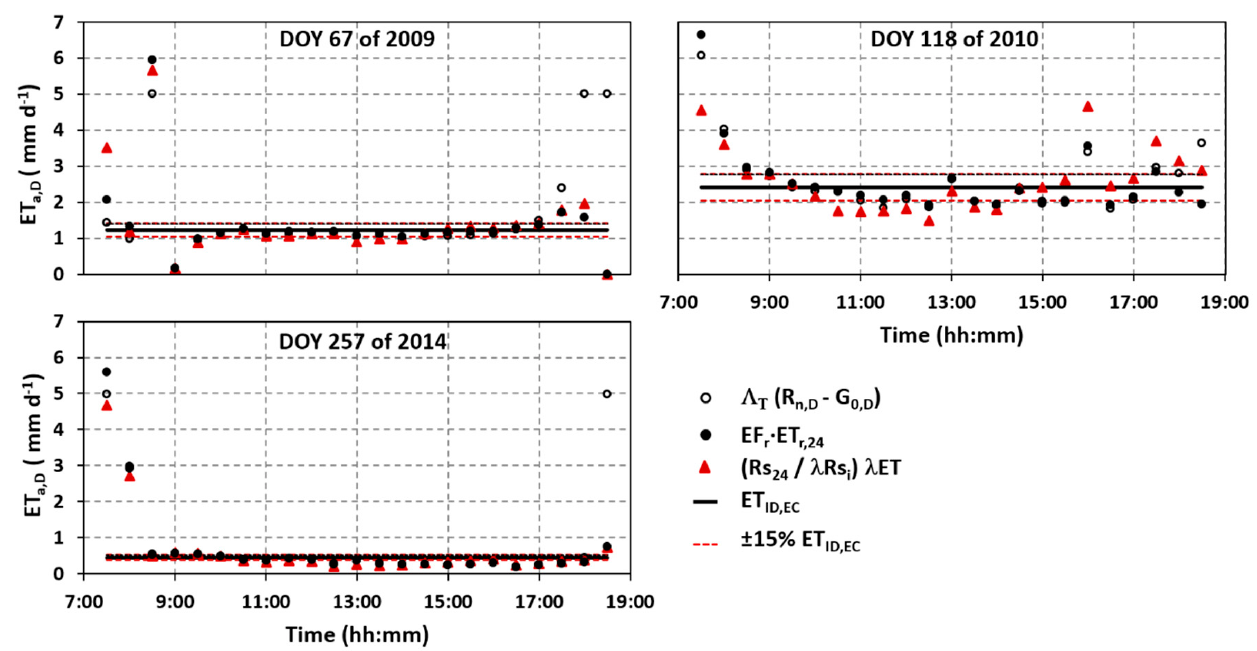
Figure 5. Daytime temporal variability of 30 min tower-derived and upscaled ET a,D based on Λ T , ET r and Rs 24 /Rs i , and EC measured daily actual ET (ET ID, EC ) during DOY 67-2009, 118-2010 and 257-2014. The red dashed lines indicate a ± 15% ET ID, EC interval.